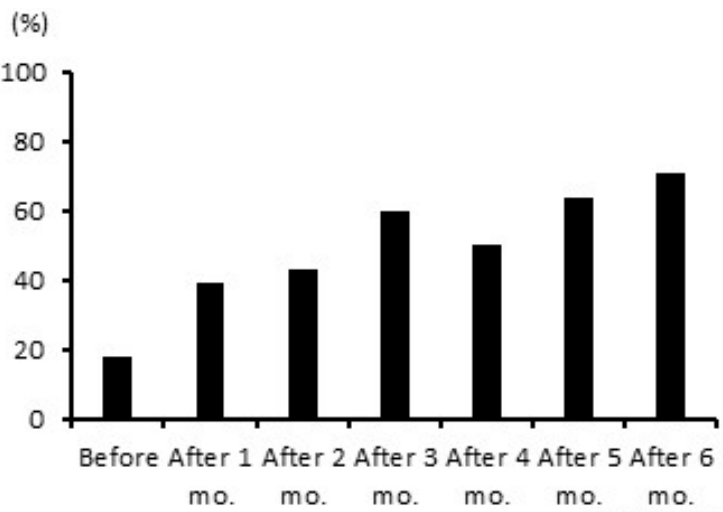
Figure 3. Taste thresholds during 6 months of zinc replacement therapy. Subjects: Twenty-eight patients on hemodialysis with serum zinc levels < 80 μ g/dL (male: 19, female: 9). Methods: Nobelzin ® tablets (zinc acetate dihydrate) were orally administered to maintain serum zinc levels within 70–120 µ g/dL, and salty taste thresholds were measured with the “SALSAVE ® impregnated paper test”. Those who could taste salt in the salt-impregnated filter paper with the lowest salt concentration were considered to have normal taste, the percentage of whom is shown.